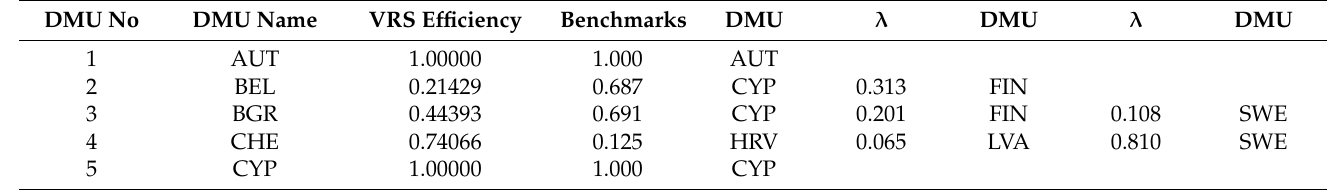
Table A2. Input-Oriented VRS Efficiency of EPS in 2014. Source: Authors’ calculations in DEAFrontier. DMU